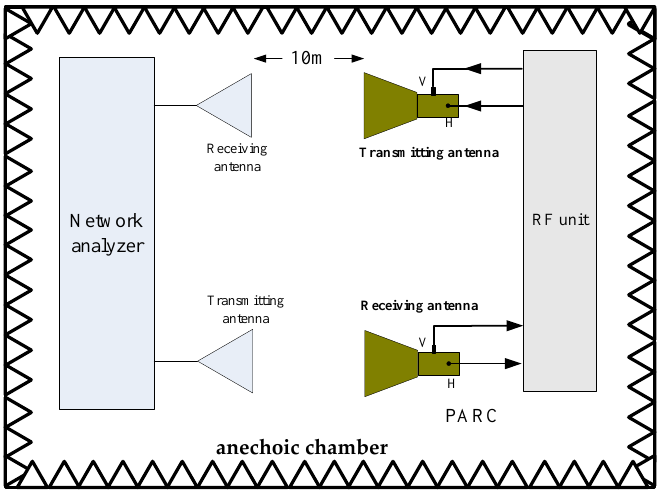
Figure 9. Configuration for the radar cross section (RCS) measurements.